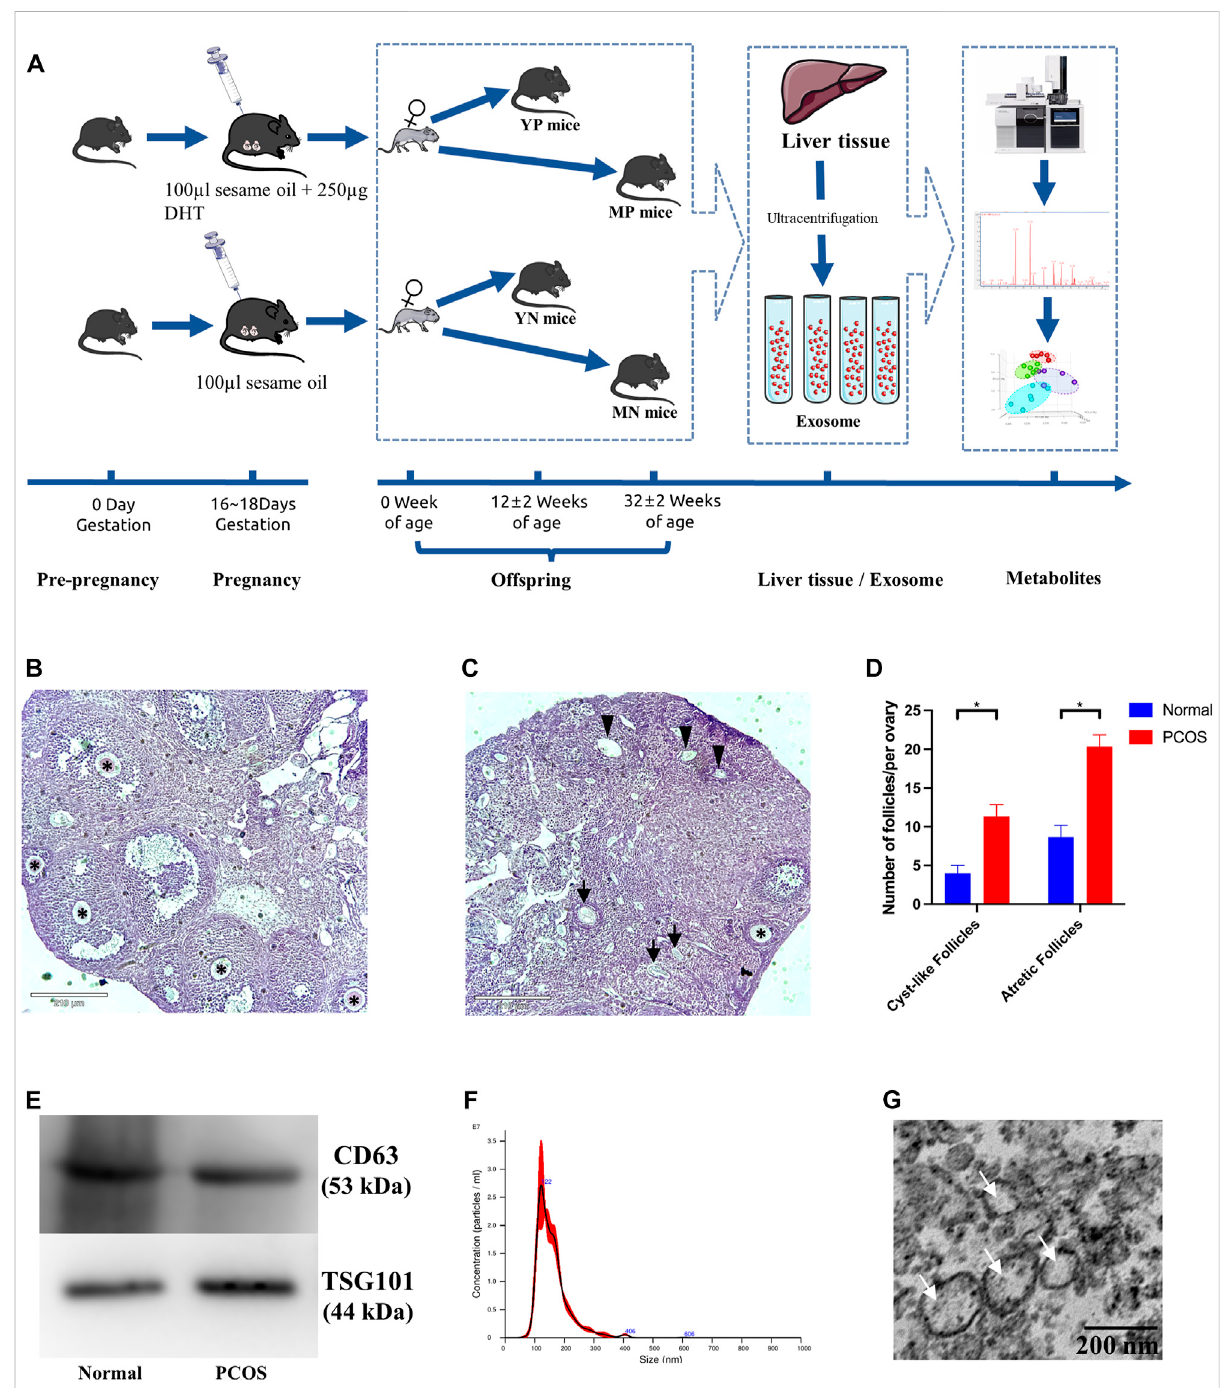
FIGURE 1 (A) Overview of PCOS modeling process. Morphological appearance and evaluation of follicles in affected ovaries from (B) normal (left) and (C) PCOSmice.Thenormalfollicleswereindicatedwithblackasterisks(*),theatreticfollicleswereindicatedwithblackarrows( ↑ ),andthecysticfollicles were indicated with black triangles ( ▲ ). (D) Bar graphs show the number of atretic follicles and cystic follicles in PCOS and normal mice (*Student ’ s t -test, p < 0.05). (E) Western blotting validated exosomes through CD63 and TSG101. (F) The size distribution of exosomes measured by the method of NTA. (G) Exosomes examined by Transmission electron microscopy